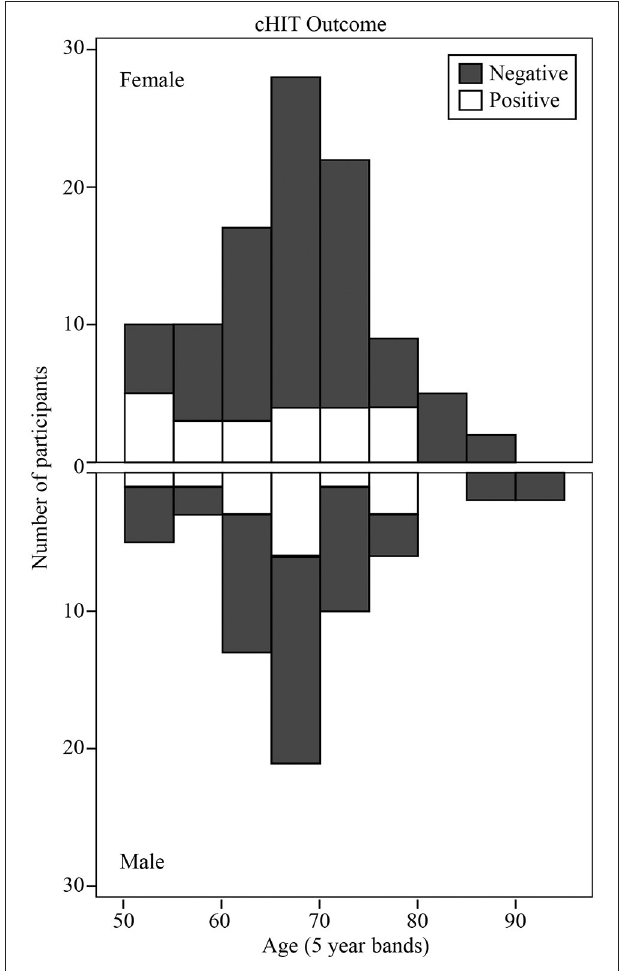
FIGURE 1 | Histogram of clinical Head Impulse Test (cHIT) results binned as Positive or Negative vs. age (with 5-years bands).